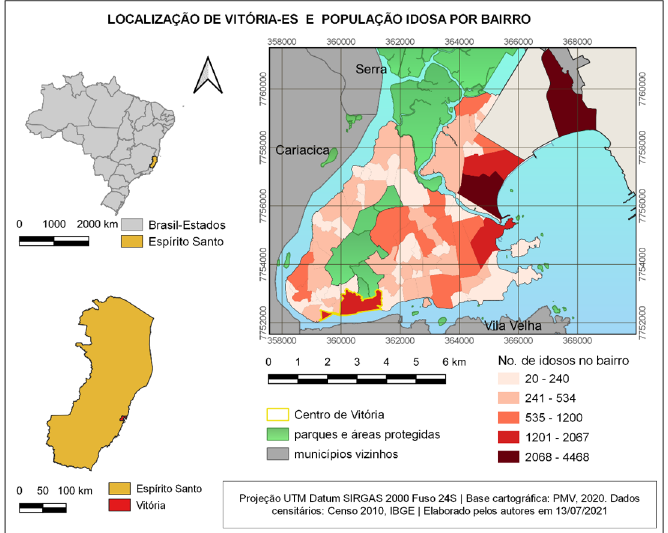
Figure 1. Location of Vitória-ES, Brazil, and older adults’ population per neighborhood. Source: created by the authors in 13 July 2021, based on GeoWeb/PMV data and cartography [54].